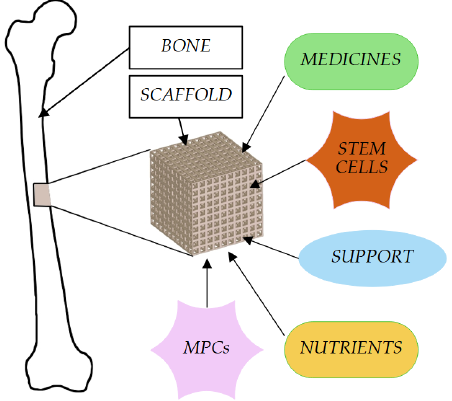
Figure 1. Usage of microporous scaffolds for supporting bone formation.